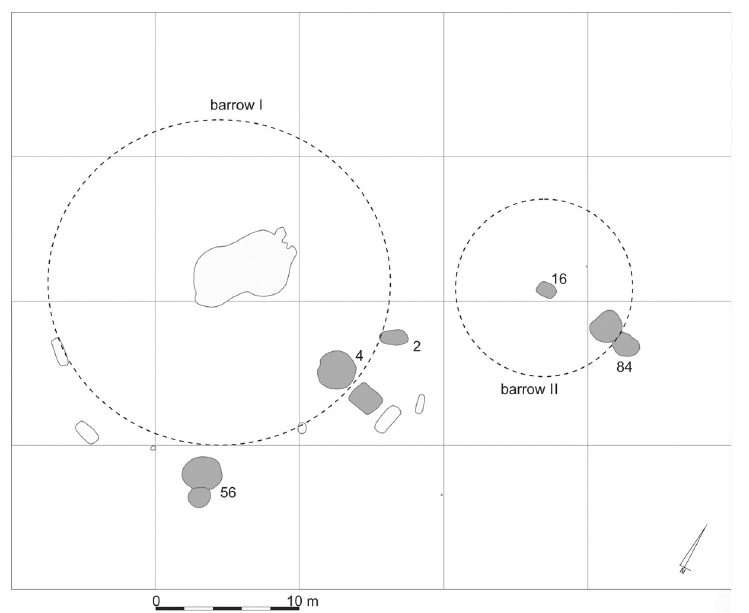
Fig 2. The configuration of graves at the analysed site 6 in